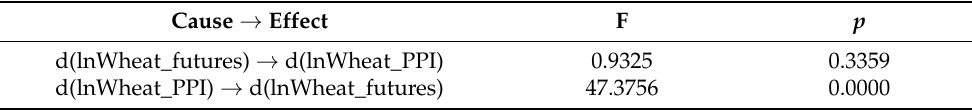
Table 3. Granger causality test of logarithmic cash and futures prices of wheat in the USA. Cause → Effect F